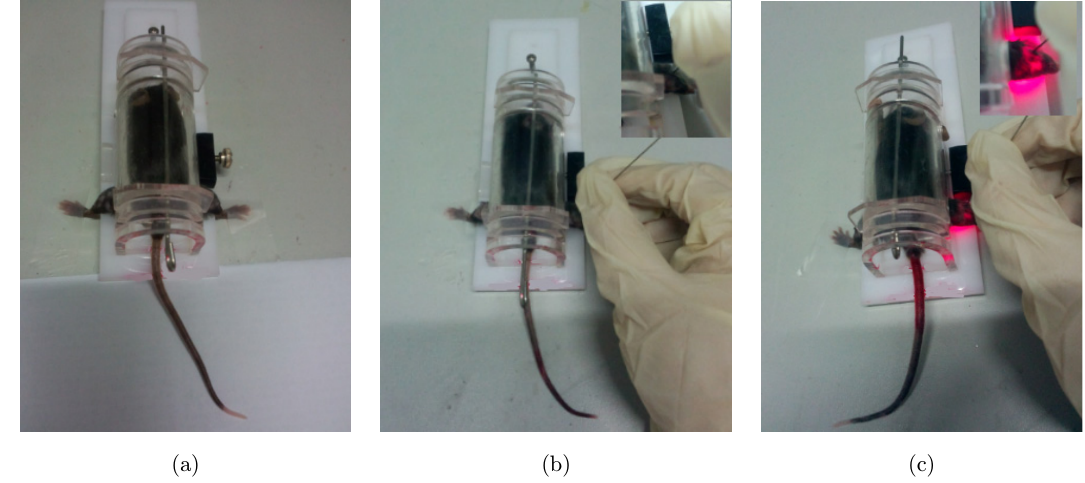
Fig. 2. The speci¯c experimental operation process of each group. (a) Control group: the mice were ¯xed in the ¯xator, and then the mice were ¯xed with adhesive tape for 10 min; (b) Hollow group: After mice were ¯xed, then applied the hollow acupuncture needling around ST36 for 10 min. (c) Laser group: Fixed mouse, then, connected the disinfection laser ¯ber needle device, and then stabbed into the mice's ST36, retaining the needle for 10